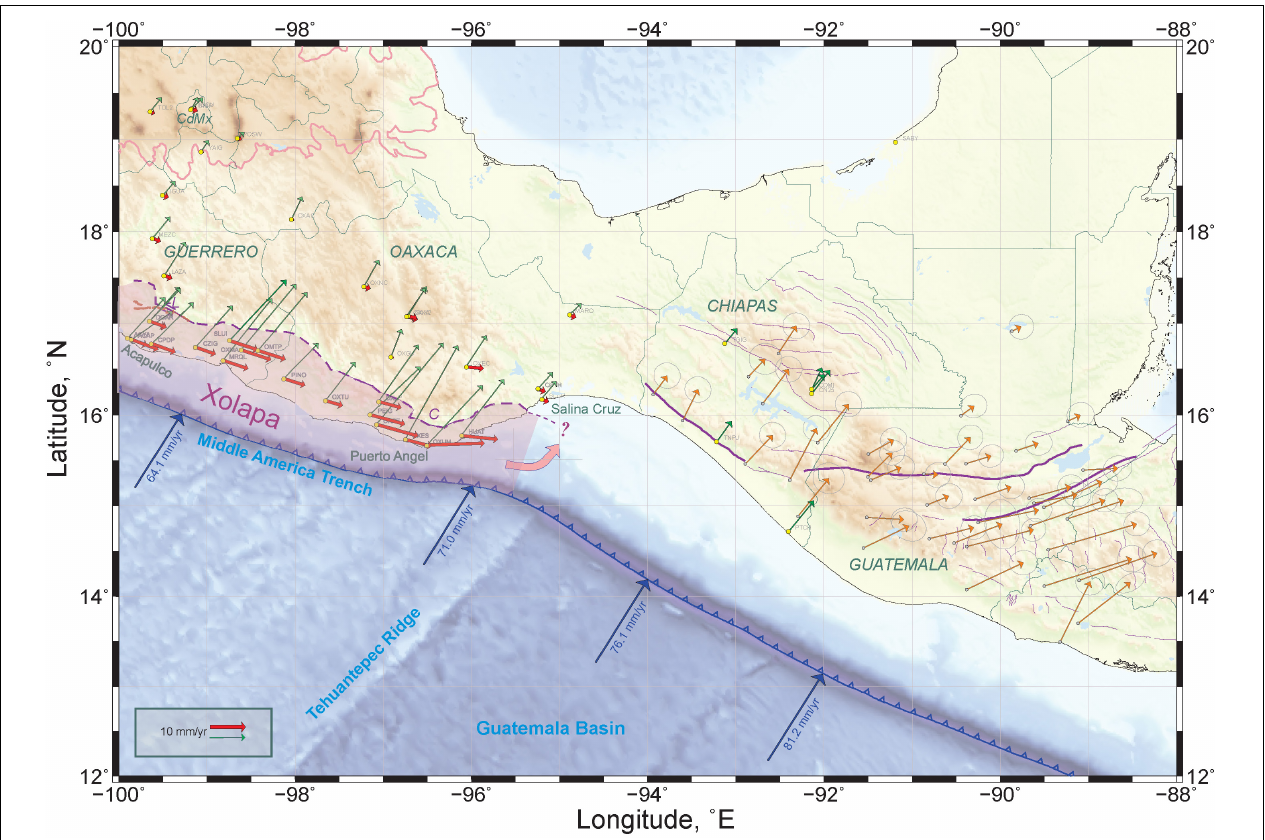
FIGURE 8 | A map of southern Mexico that illustrates models of LVC sliver progression in the Guatemala basin. There is no obliquity in the Cocos–North America convergence offshore of the Chiapas segment of the MAT (-95.0 to − 92.0 ◦ E). That causes an absence of a driving force for the sliver at a distance of more than 300 km along the MAT. Pink curved arrow indicates probable northward bending of the Xolapa sliver. Orange GPS vectors in Chiapas and Guatemala are from Ellis et al. (2018). Other captions are the same as in Figure 1